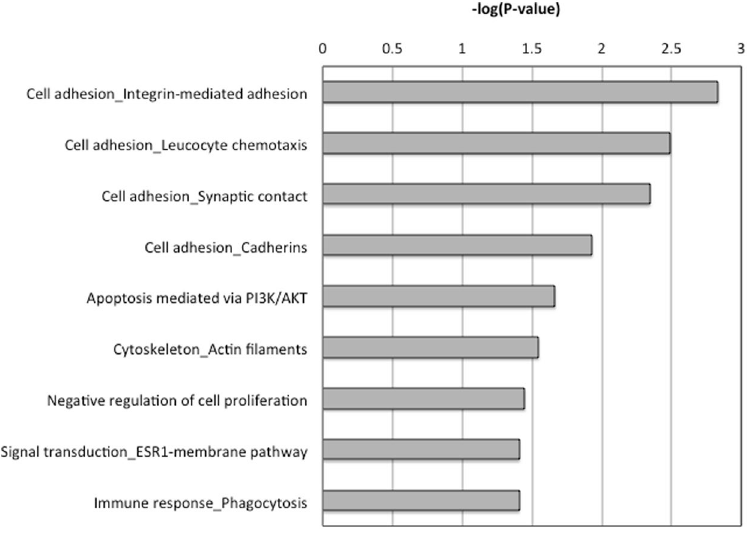
Figure 4. Metacore based pathway enrichment analysis of gene associated DMRs in atherosclerosis reveals a significant (P-value < 0.05; − log(P-value) < 1.3) enrichment of CVD related pathways related to leukocyte chemotaxis and